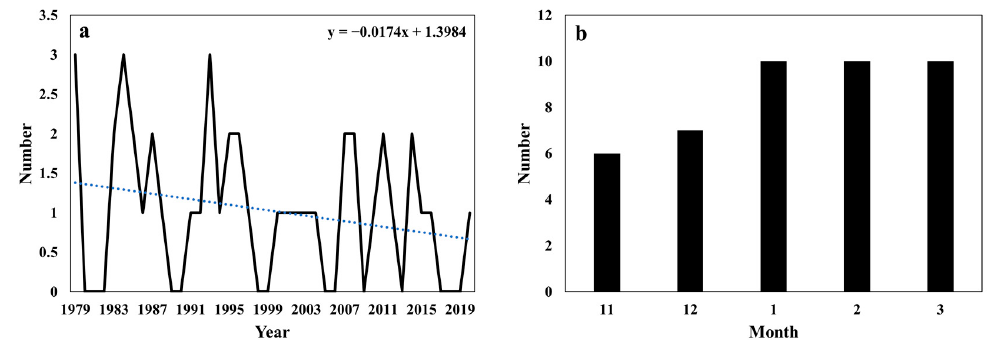
Figure 1. ( a ) the interannual variation of the frequency of blocking high (unit: time), and ( b ) the number of blocking high occurring every month (unit: time) in the Ural Mountains.